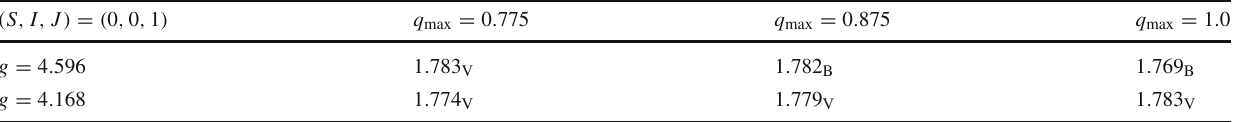
Table 2 Pole positions (in GeV) evaluated with different values for the cutoff q max (in GeV) and the coupling constant g . The subscripts B and V stand for bound state and virtual state, respectively ( S , I , J ) = ( 0 , 0 , 1 ) q